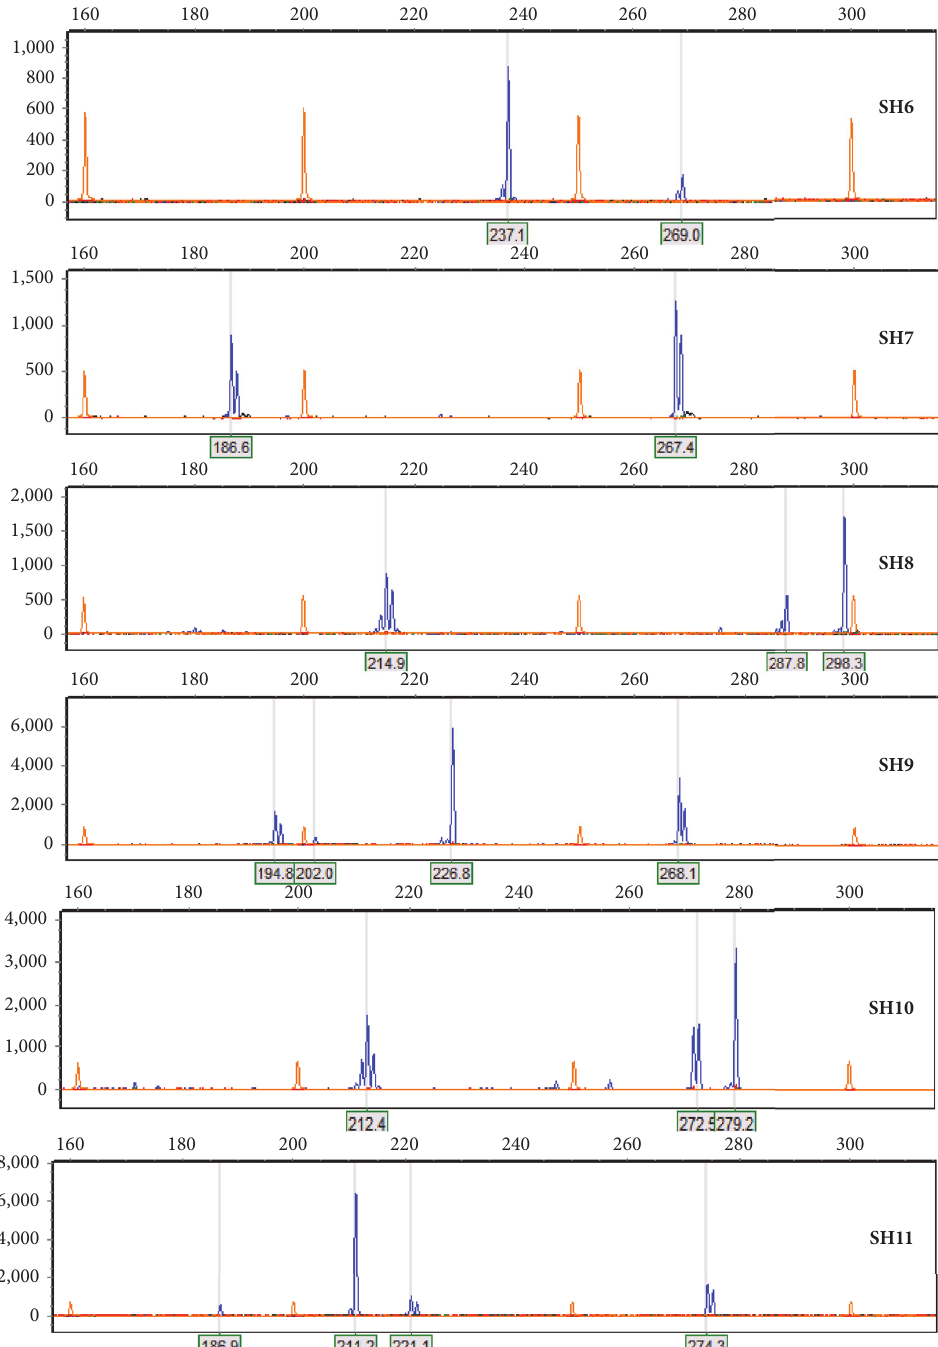
Figure 2: Electropherograms showing capillary electrophoresis separation of the PCR product fragments amplified from ecotypes with the three primers. The horizontal axis displays the size of the detected PCR product fragments, while the vertical axis presents the intensity of the signal (i.e., the indicator of concentration of fragments in the PCR products). The orange peaks match the standard fragments in the GeneScan 500 LIZ size standard, while the blue ones represent the PCR products fragments amplified from different ecotypes. The numbers on the horizontal axis represent the size of the corresponding peak in the GeneScan 500 LIZ size standard (orange). “LH” represents Landoltia punctata haplotype number and “SH” represents Spirodela polyrhiza haplotype number. Different haplotypes displayed different types of blue peaks (DNA fragments) and